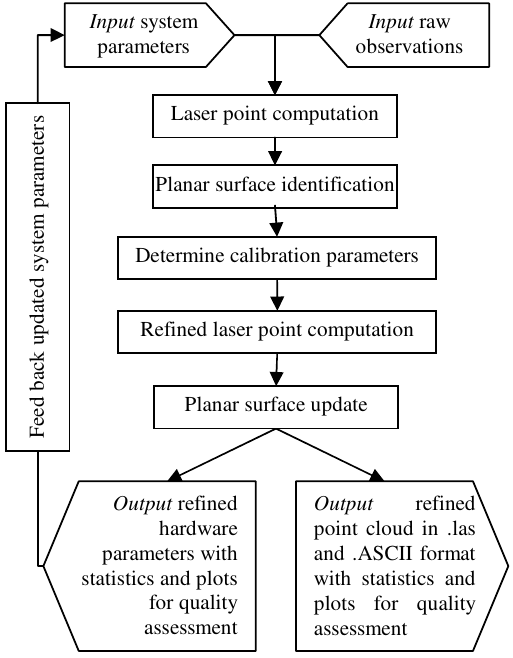
Figure 1. Iterative refinement of